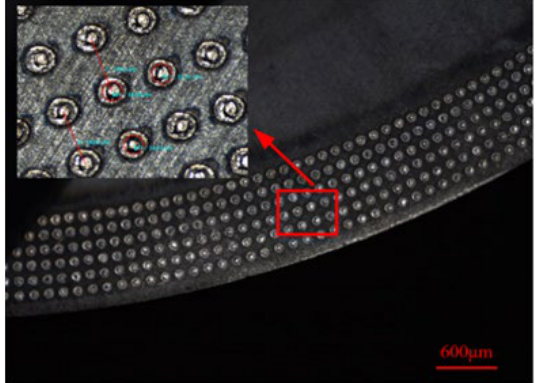
Figure 5. Texture parameter detection diagram.